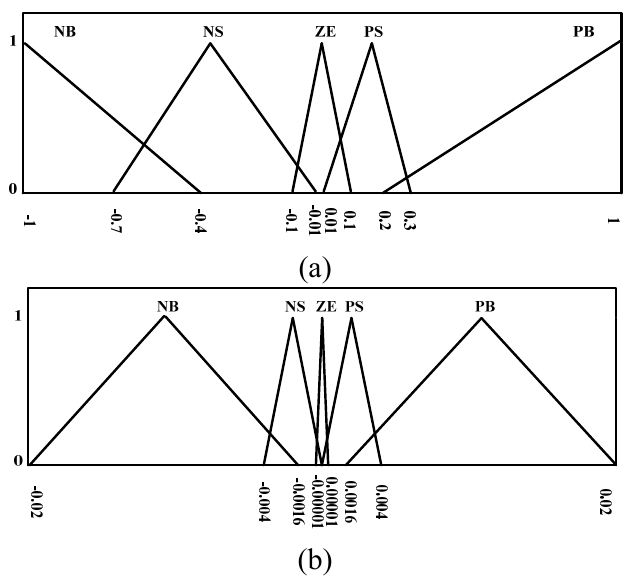
Figure 25. Membership functions for Algorithm (v): ( a ) Membership function for / / I V dI dV  , ( b ) Membership function for increment of duty ratio PV PV PV PV